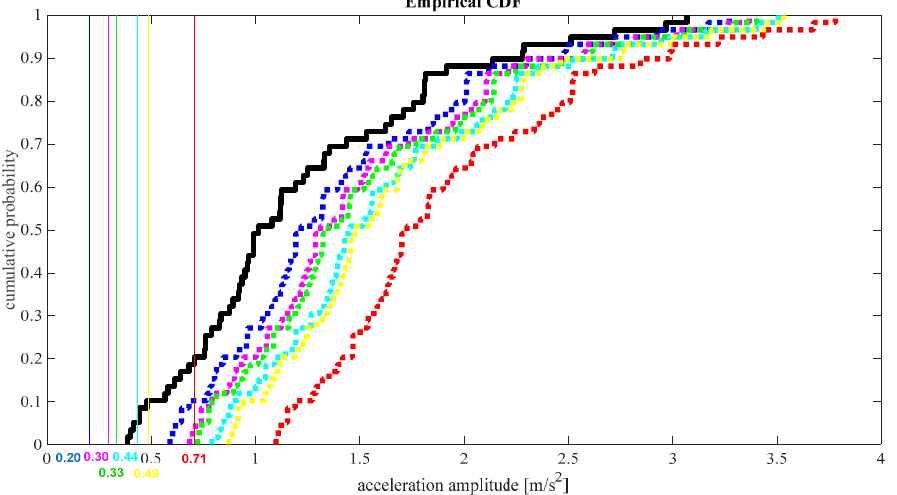
Figure 15. Empirical cumulative distribution functions (CDFs) based on 7 times of 59 maximum acceleration amplitudes (intensity 7) induced by different ground accelerations (1 black wide solid curve) and by both earthquake and crowd loads (6 dashed curves: the blue wide dashed curve for low density of 0.1 pedestrians/m 2 , the red dotted wide curve for high density of 1.5 pedestrians/m 2 , and other dashed curves for other densities: pink for 0.2, green for 0.8, cyan for 0.5, yellow for 1.0). For comparison, six additional vertical straight lines are added as the induced maximum responses by the low density of 0.1 pedestrians/m 2 crowd (the blue narrow solid line of 0.20 m/ s 2 ), the high density of 1.5 pedestrians/m 2 (red narrow solid line of 0.71 m/ s 2 ) crowd, and four other density cases (pink for 0.2, green for 0.8, cyan for 0.5, yellow for 1.0).